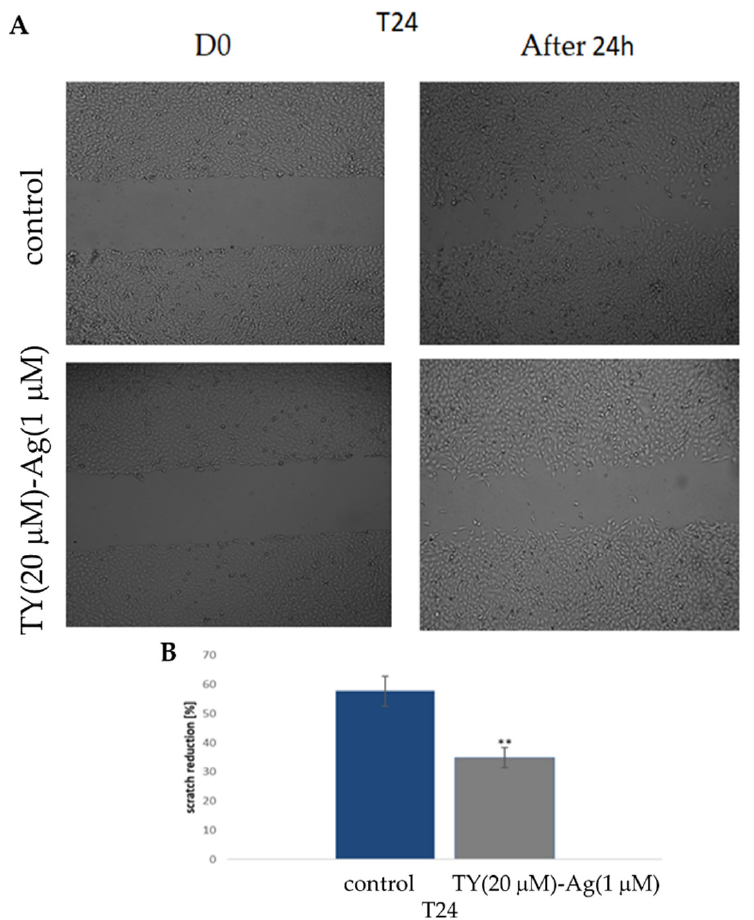
Figure 15. The effect of TY(20 µ M)-Ag(1 µ M) on the motility of T24 cells ( A ): exposure to TY(20 µ M)-Ag(1 µ M) inhibited migration of T24 cells in a scratch assay observed after 24 h; ( B ): percentage of scratch reduction after 24 h ( n = 3).